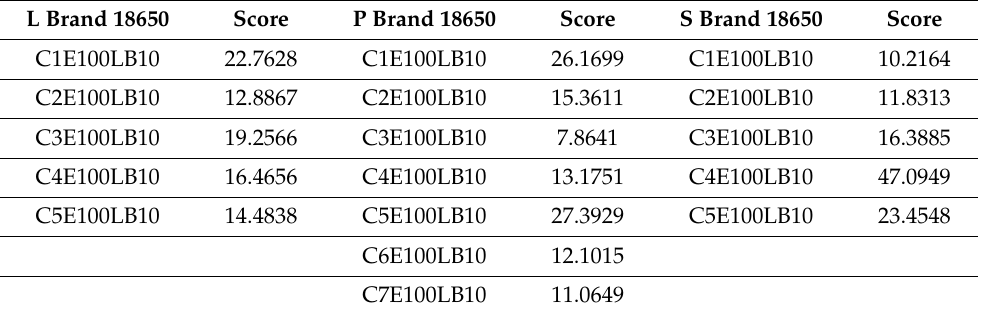
Table 3. Results of RNN, Epoch = 100, look_back = 10.